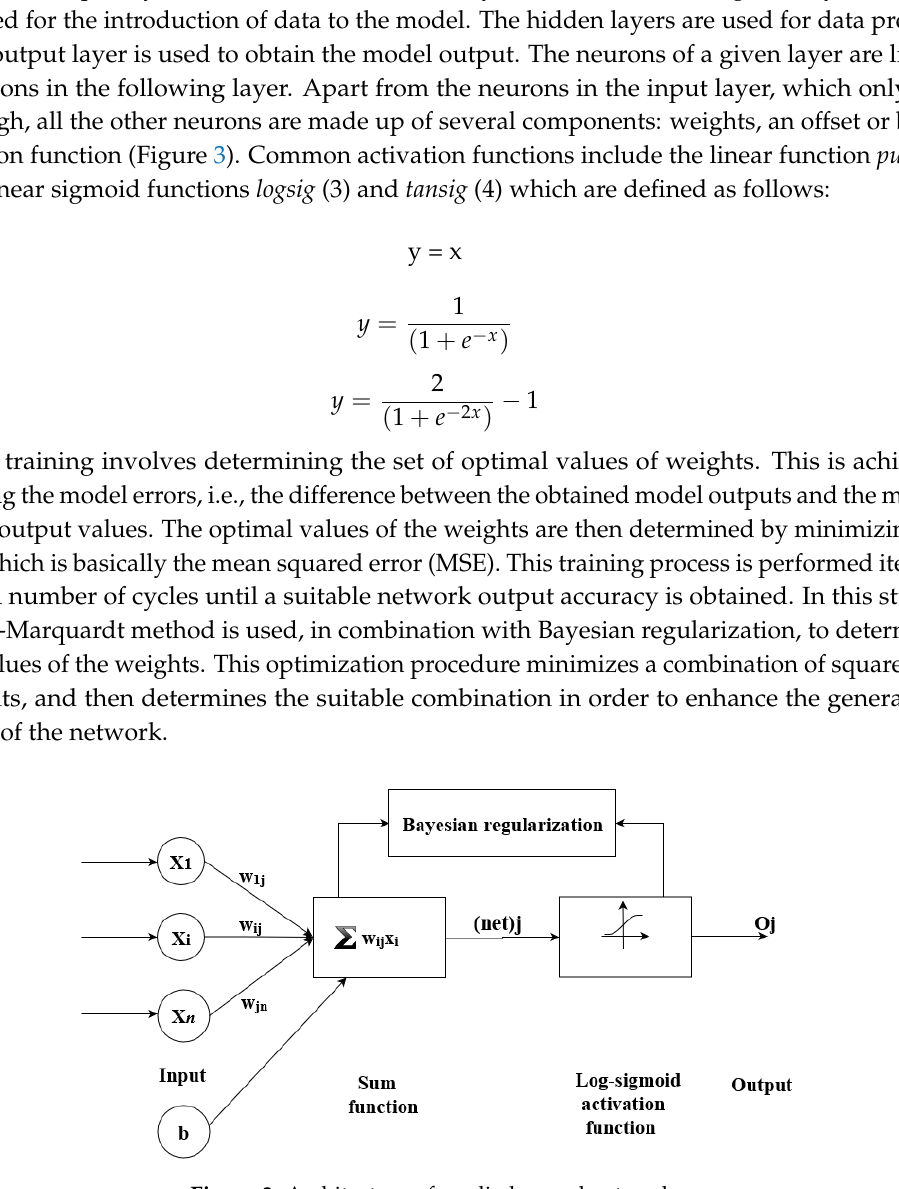
Figure 3. Architecture of applied neural network.